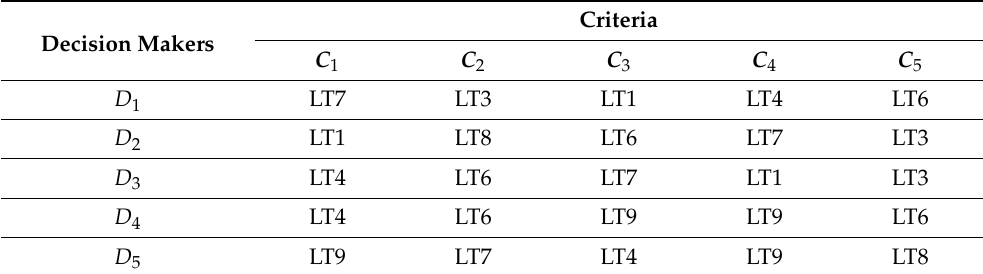
Table 4. Economic factor weights of the criteria assessed by the decision-makers. Decision